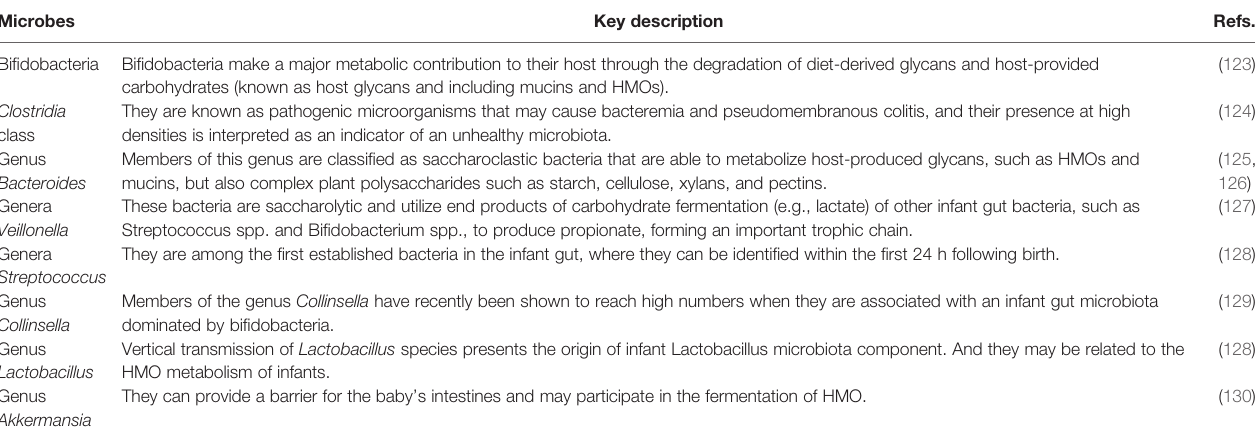
TABLE 4 | The dominant populations of infant gut microbiota.